Question: What type of chart is this?
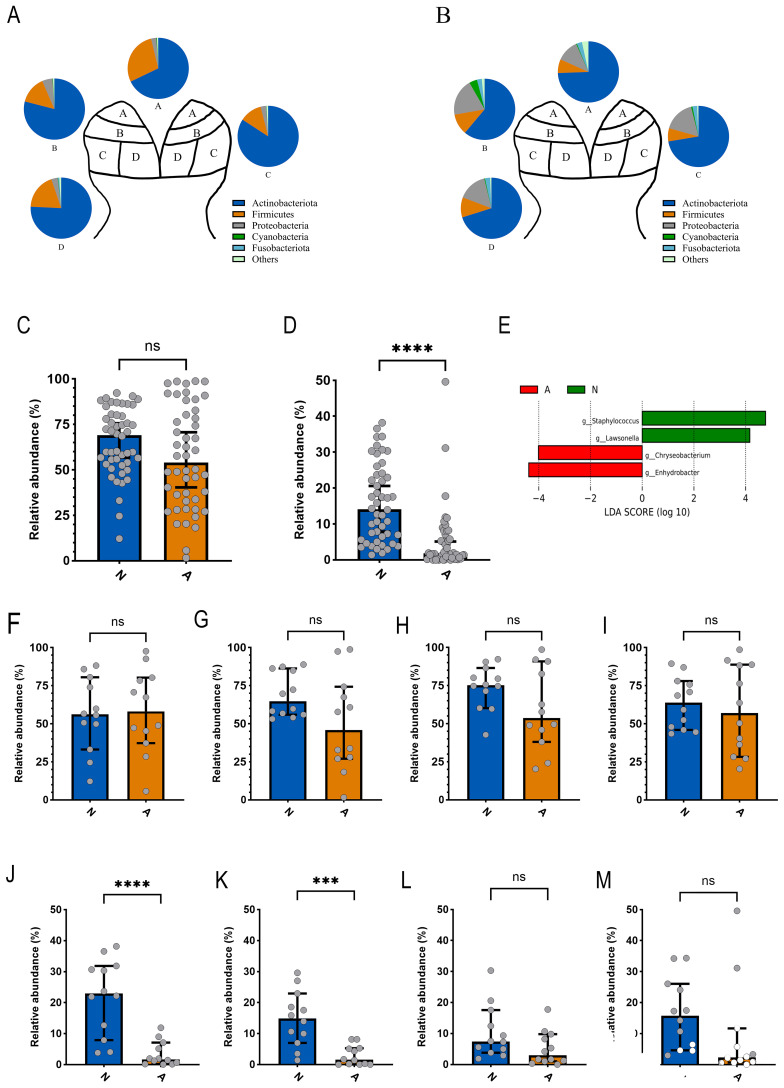
Answer: pie